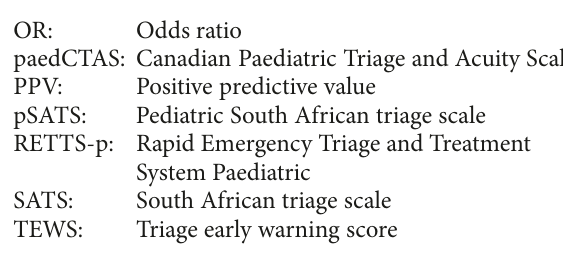
Figure S1: The pSATS triage form. The triage form is translated by the first author and contains the modified discriminator list and TEWS tables for the six age groups.